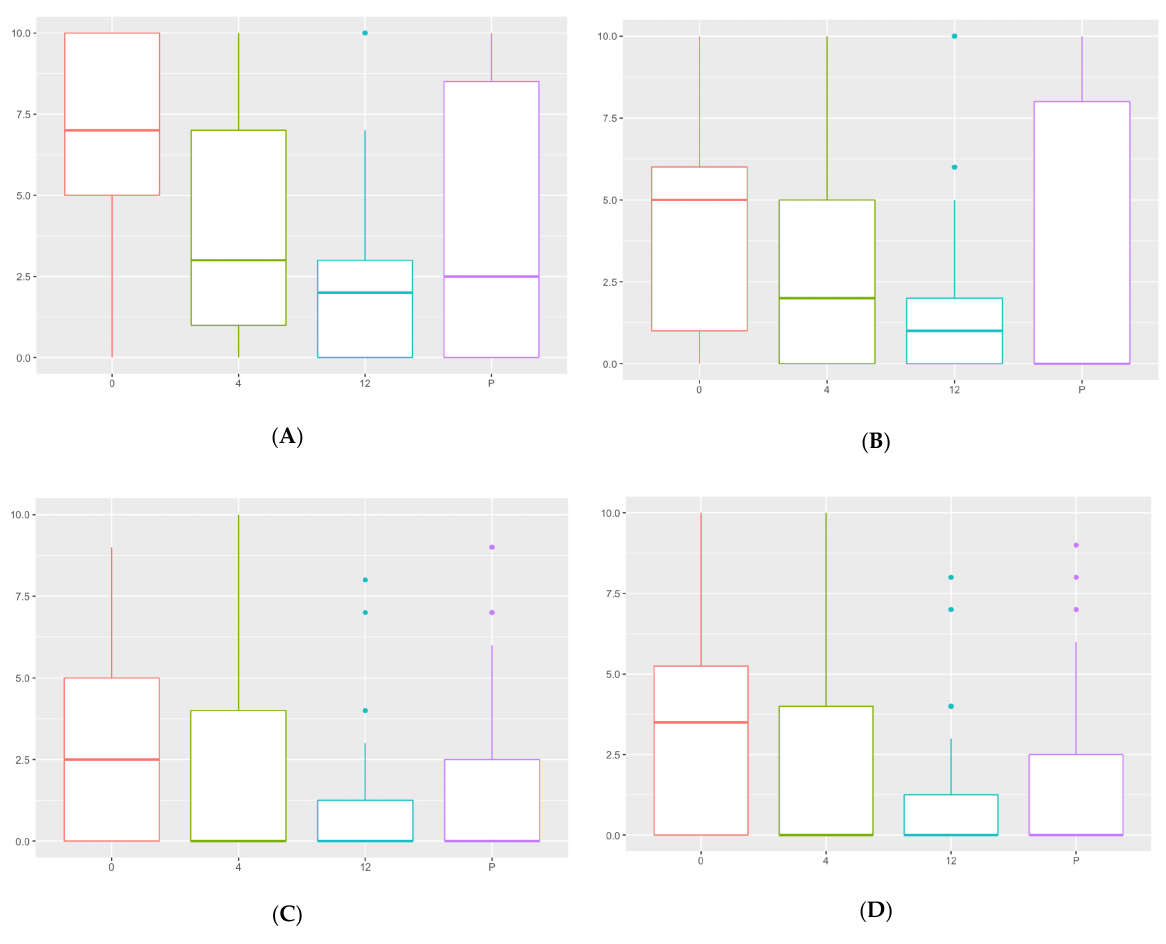
Figure 4. Comparative analysis of the capacity to walk, run, and climb up and down stairs. The X axis represents the time in months (0: prior to surgery; 4: four months after surgery; 12: twelve months after surgery; P: present). The Y axis represent the score, 0: not painful and 10: painful. ( A ) The capacity to walk without pain; ( B ) the capacity to run without pain; ( C ) the capacity to climb up stairs; and ( D ) the capacity to walk down stairs.